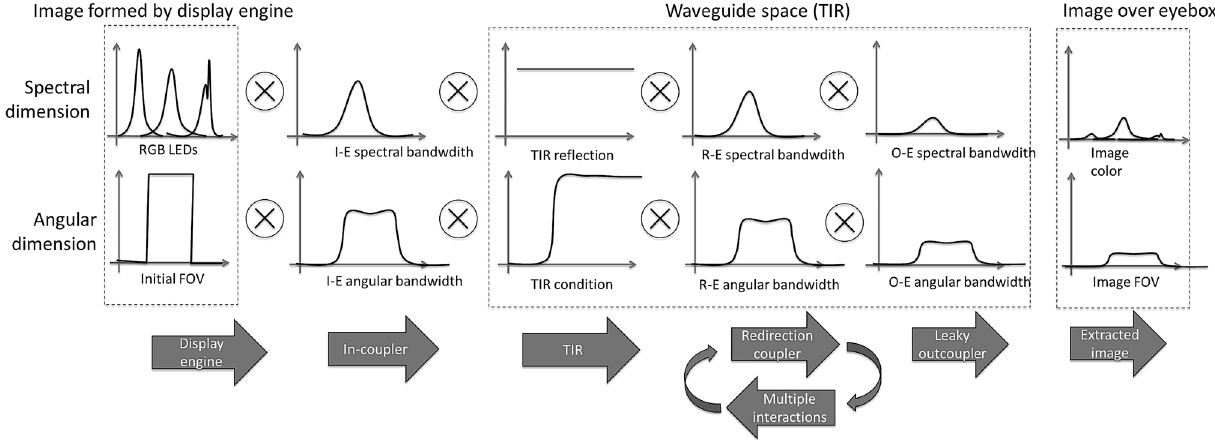
Figure 18: Cascaded effects of the field/coupler interactions on the FOV